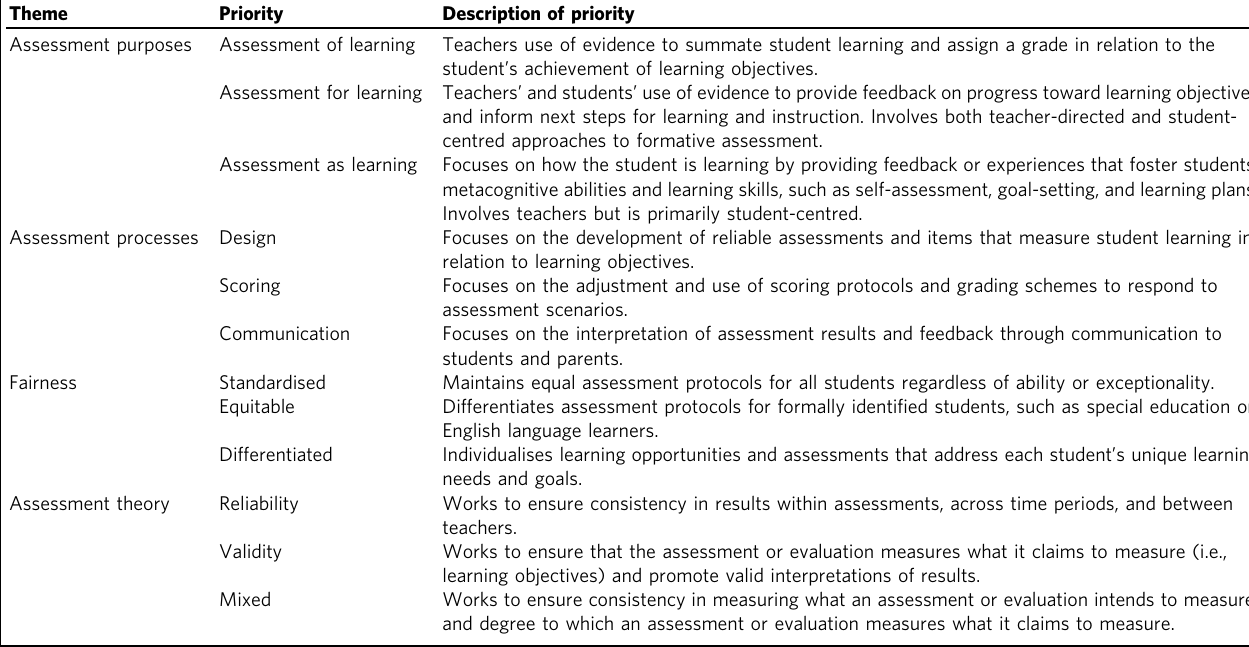
Table 2 ACAI assessment dimensions and sets of